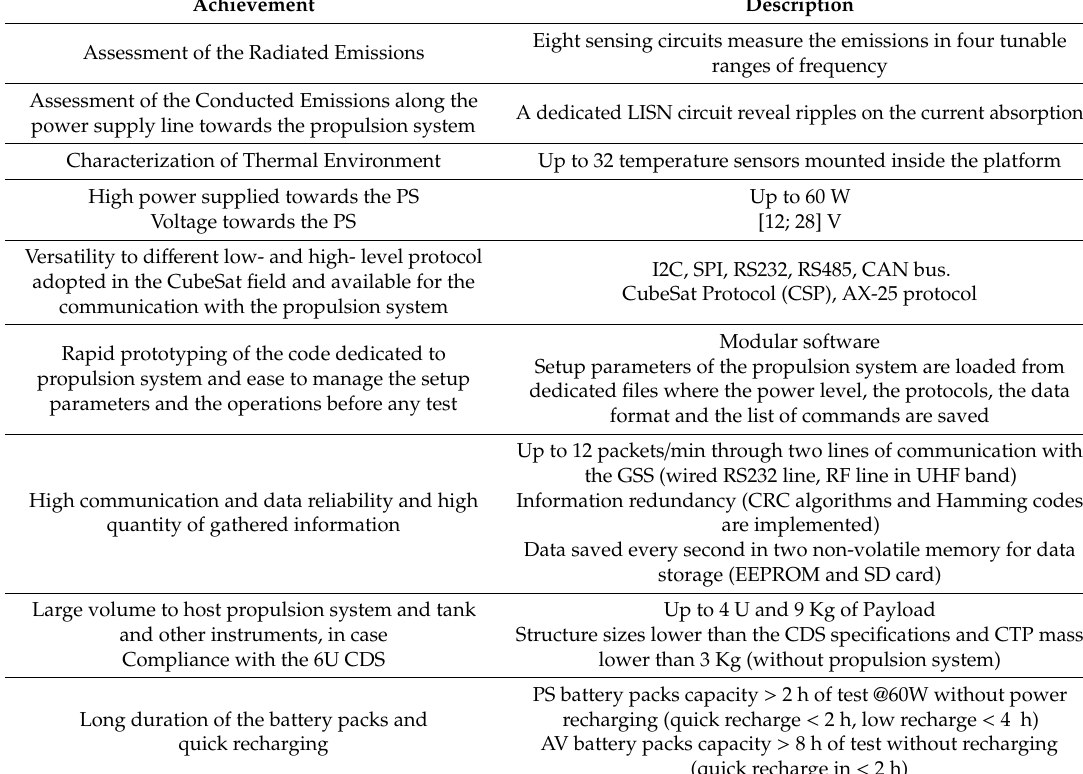
Table 1. Main achievements of the